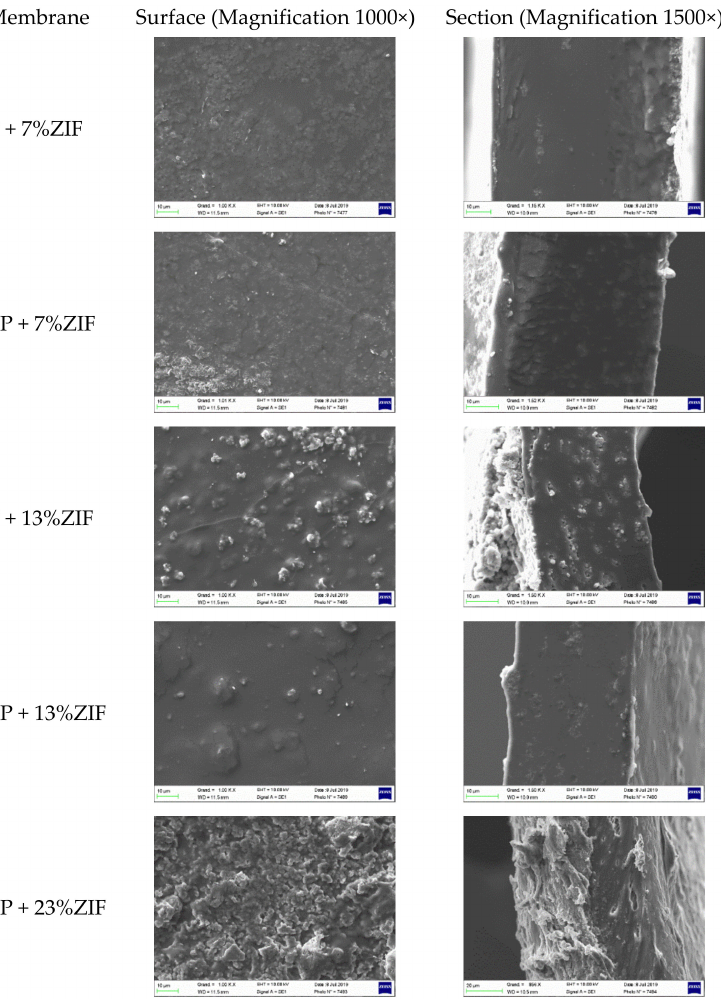
Figure 5. Surface and cross-section morphology of Pebax/ZIF-8 and Pebax/PEG/ZIF-8